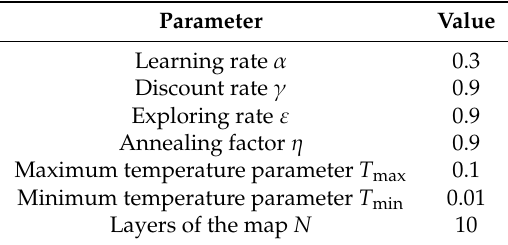
Table 1. Experimental